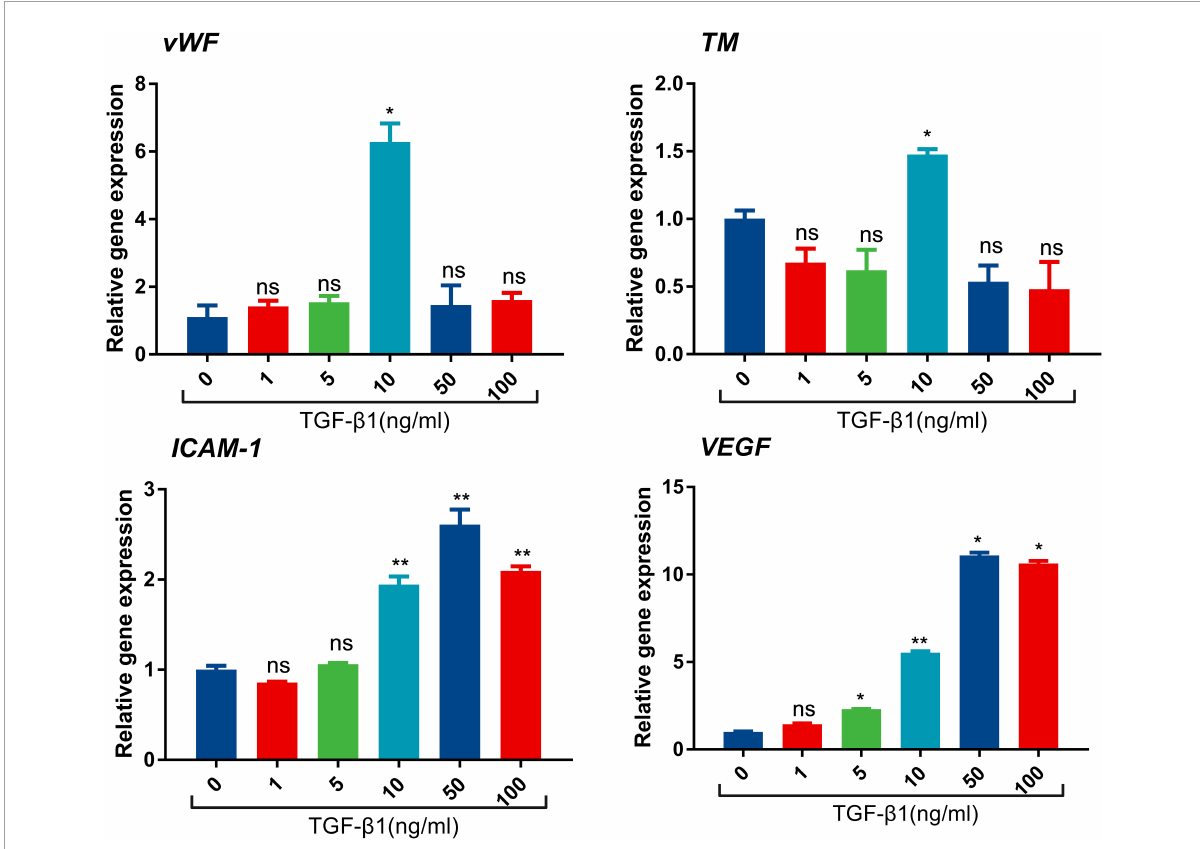
FIGURE2 mRNA expression of vWF, intercellular adhesion moleclar-1 (ICAM-1), TM, and VEGF after the treatment of TGF- β 1 in endothelial cells. (* p < 0.05, ** p < 0.01). Data are expressed as mean ± SEM. Three replicates per